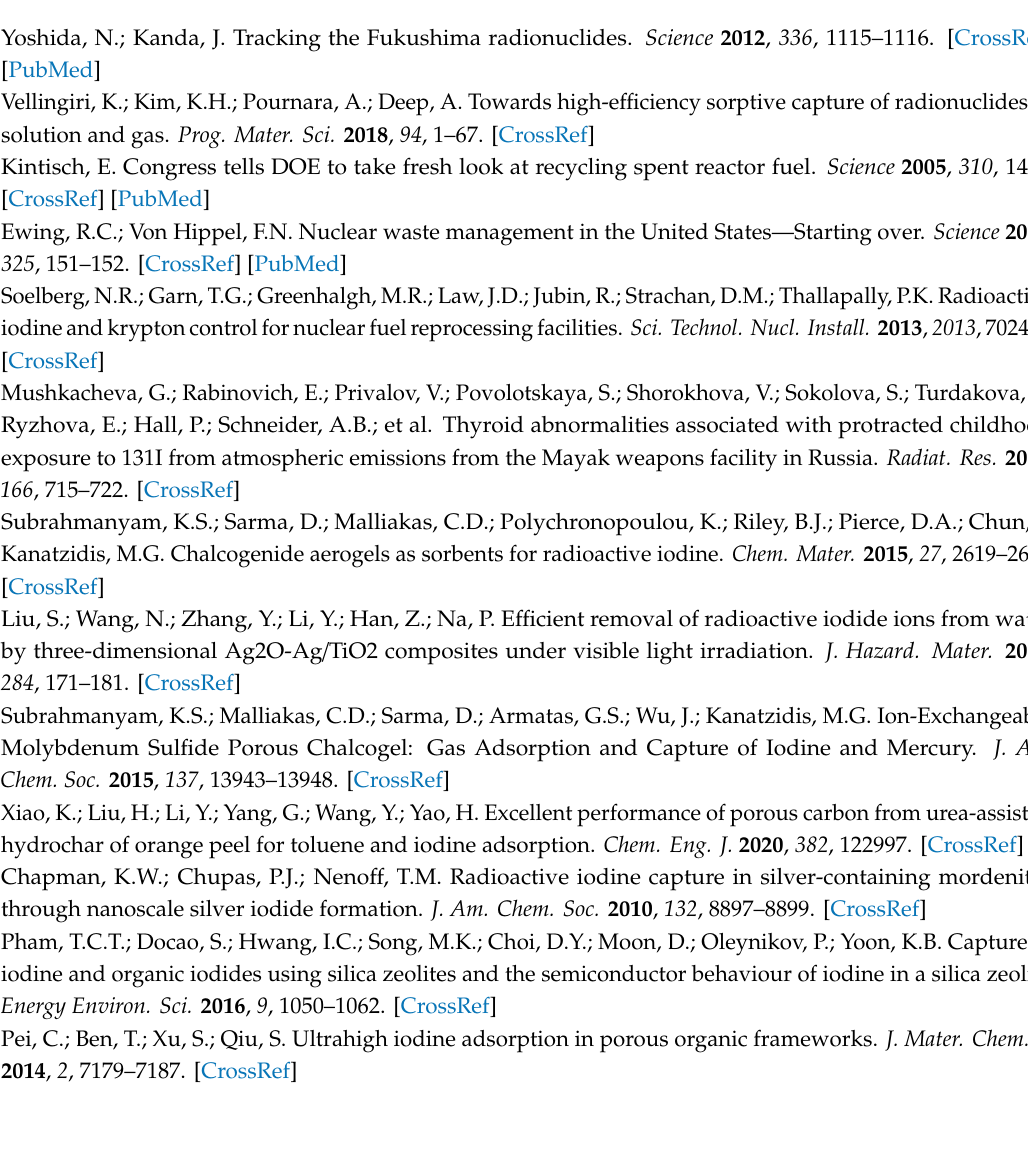
Table S1: Adsorption energy values of di ff erent oxygen-containing group, Table S2: Bond distances of di ff erent oxygen functional groups, Figure S1: Distinct structures of oxygen functional groups on perfect surface of graphene. The carbon atoms activated by neighboring oxygen functional groups are within red circles, Figure S2: Distinct structures of oxygen functional groups on three kinds of defected surfaces of graphene. The carbon atoms activated by neighboring oxygen functional groups are within red